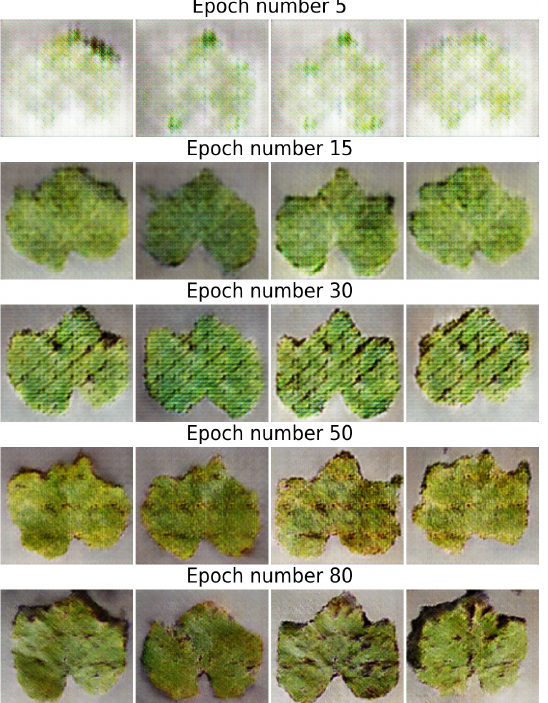
Figure 4. GAN-generated images for the leaf blight class after a certain amount of training epochs.